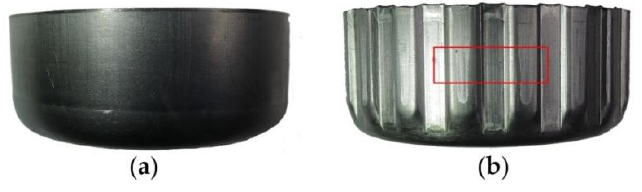
Figure 9. Surface appearance before and after the clutch forming process without vibration: ( a ) Before forming; ( b ) After forming.